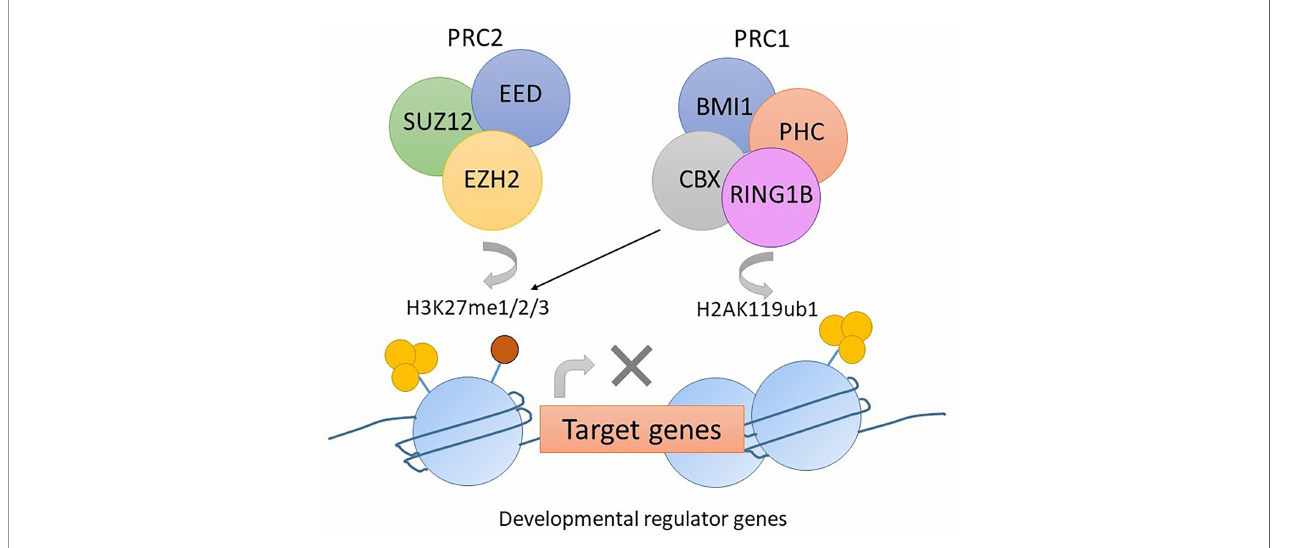
FIGURE 3 | The function of PRC2 complex in normal hemopoiesis. EZH2 mediates the methylation of lysine 27 of histone 3 tail (H3K27me3). The histone modi fi cation H3K27me3 recruits PRC1. CBX in PRC1 mediates mono-ubiquitylation of lysine 119 of histone 2A (H2AK119ub). Gene transcription is suppressed due to histone modi fi cation.